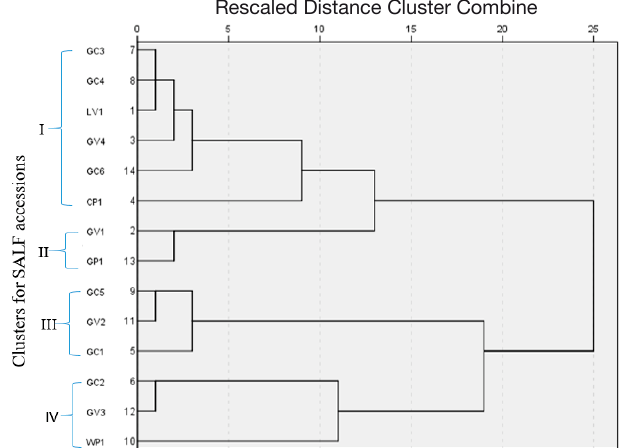
Fig. 5: A dendrogram representing diversity and clusters of fourteen So- lanum anguivi Lam. fruit accessions based on their bioactive com- pounds content and total antioxidant capacity, using Ward’s mini- mum variance in hierarchical cluster analysis. Cluster 1 accessions